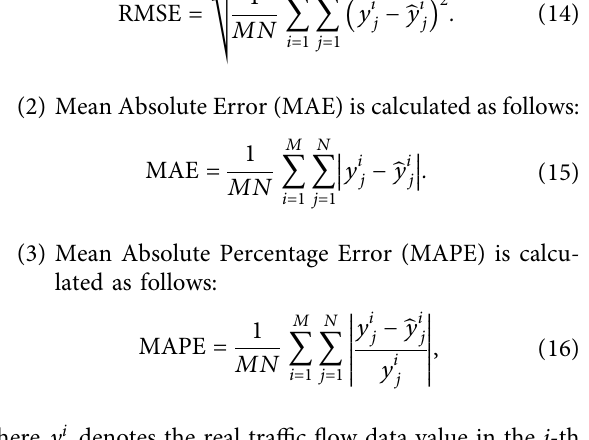
Table 1: Hyperparameter settings for different models. Models Layers